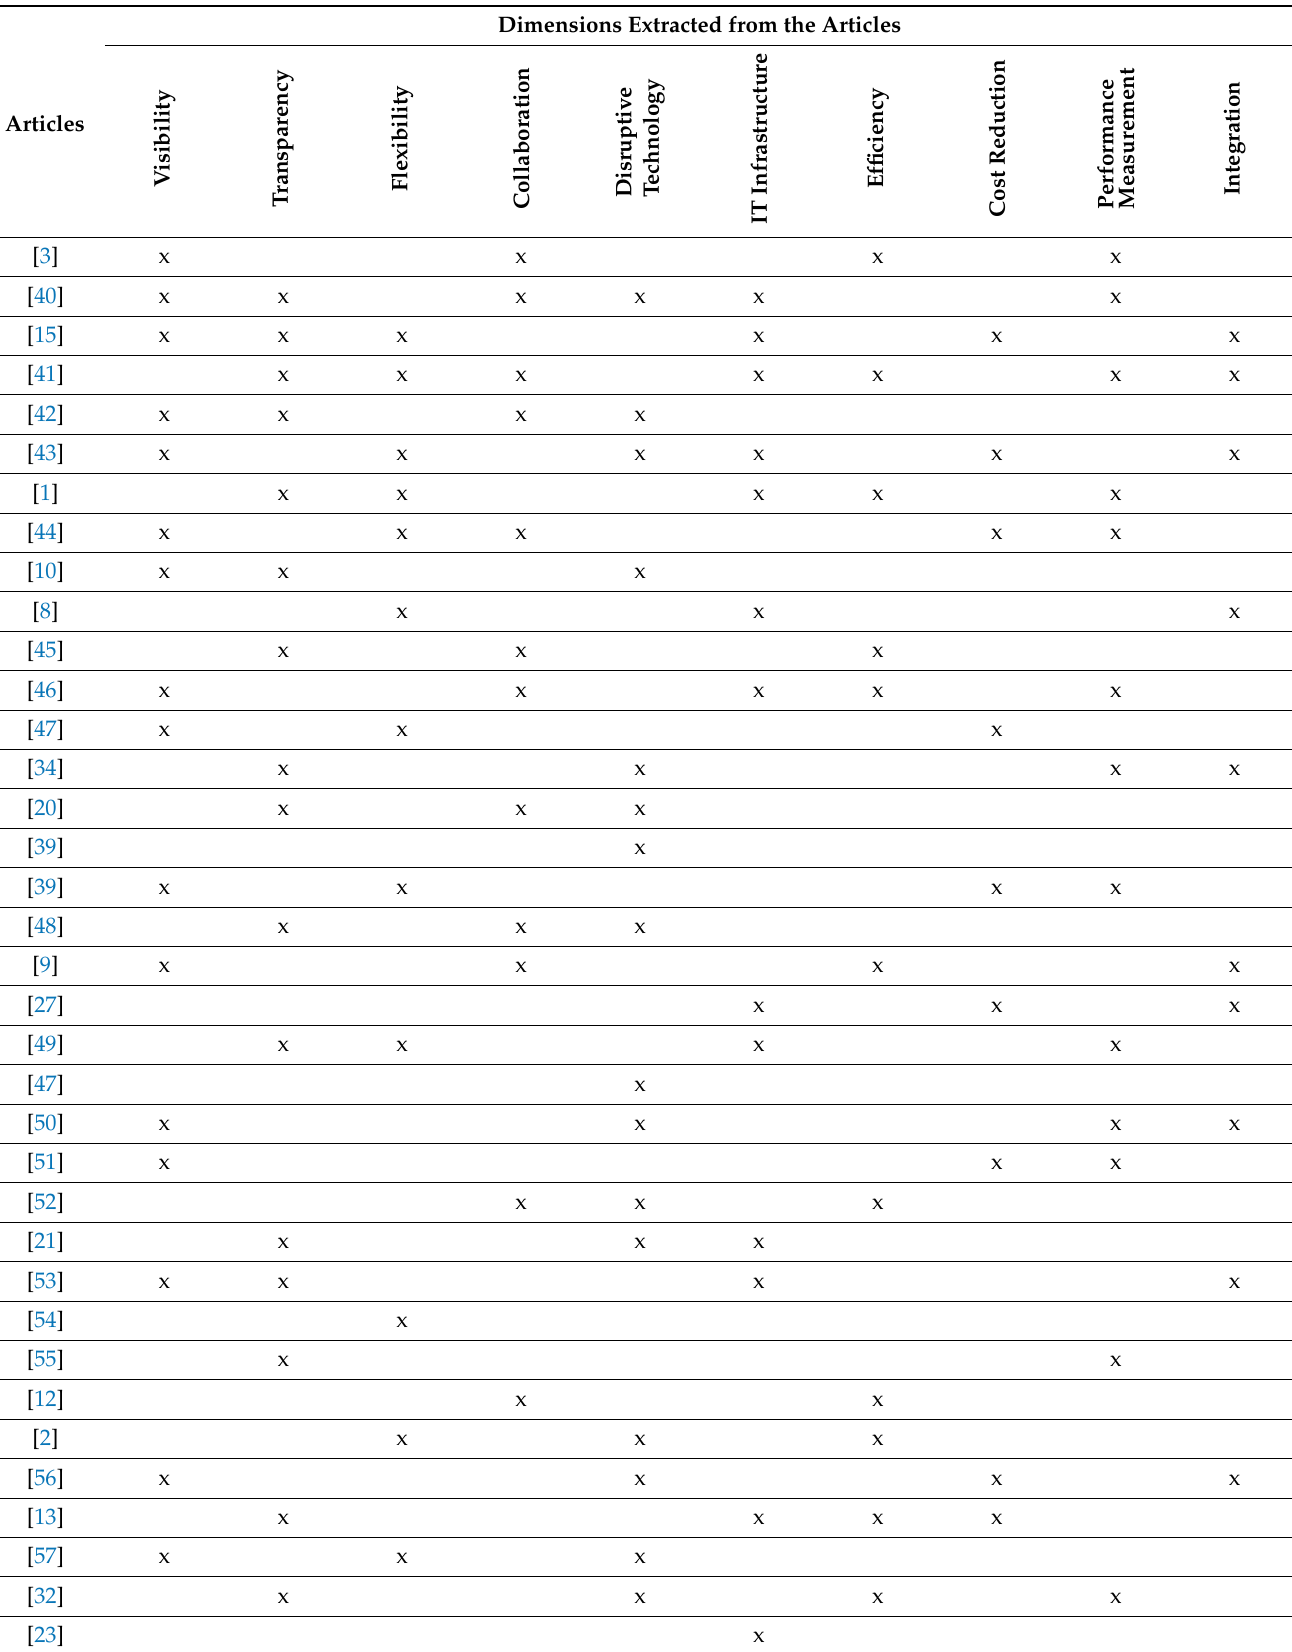
Table 5. Authors with dimensions extracted from the